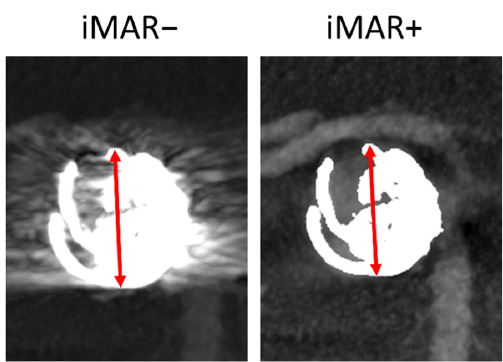
Figure 6. Exemplary CPD measurement in iMAR − /+ FD ‐ CTA images. CPD is indicated by the red arrow.